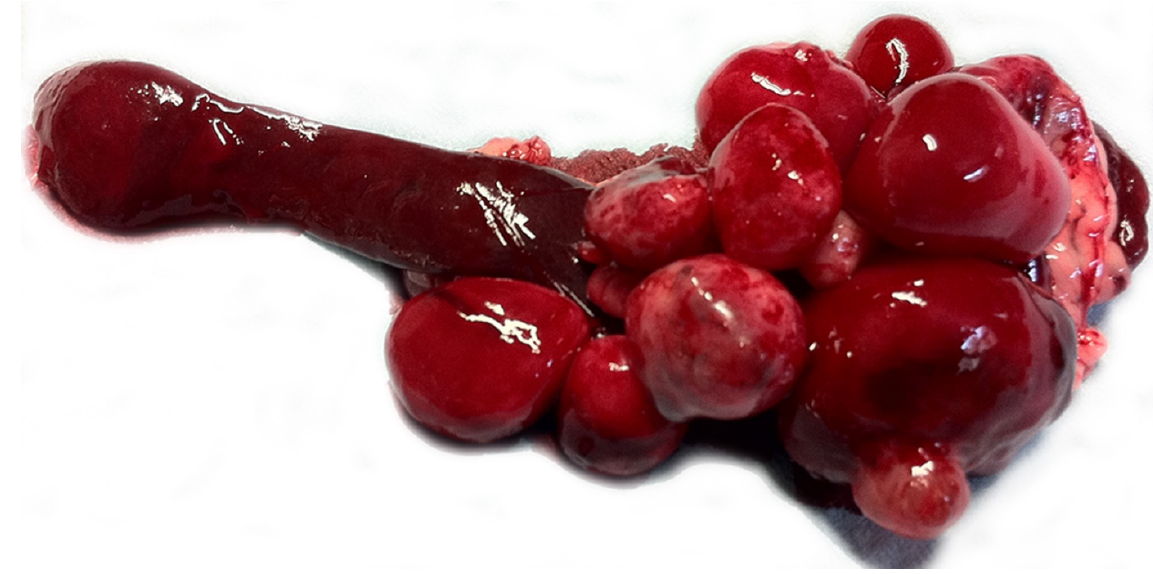
Figure 1. Inflammatory myofibroblastic tumor, spleen, cat. Multiple variably sized reddish nodules arising from the splenic capsule.